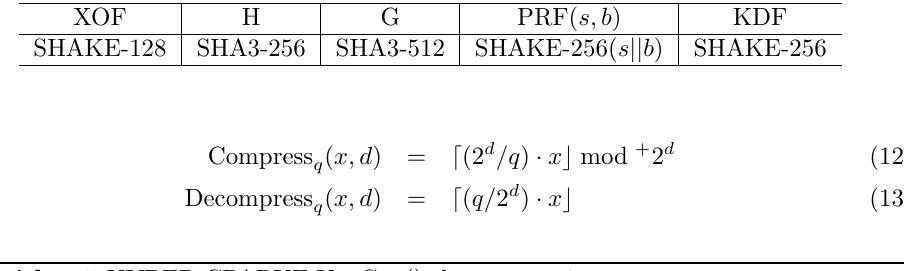
Algorithm 5 KYBER.CPAPKE.KeyGen(): key